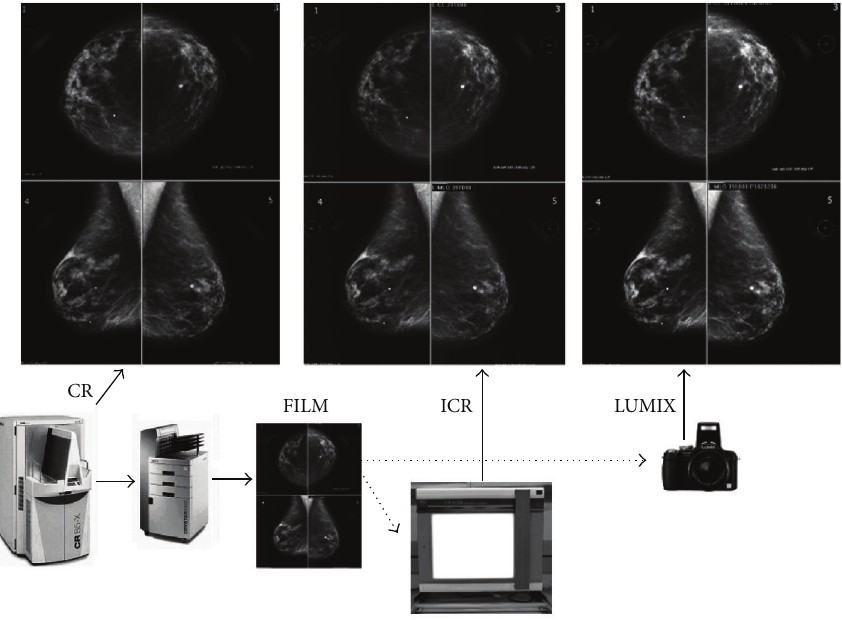
Figure 1: Digital image and film generation. CR: computed radiography; FILM: printed film; LUMIX: Lumix DMC-FZ28 digital camera; ICR: iCR 612SL specialized digitizer.